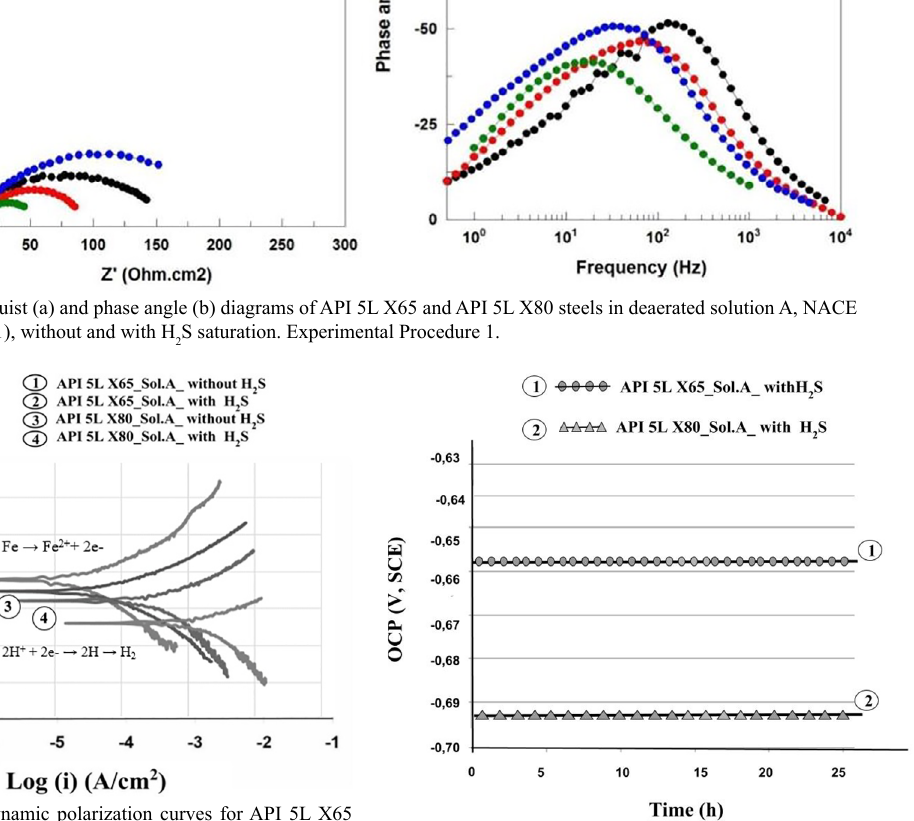
Figure 8. OCP variation for the API 5L X65 and API 5L X80 steels during 24h immersion in deaerated solution A, NACE TM0284 (2011), saturated with H S, sour medium. Procedure 2